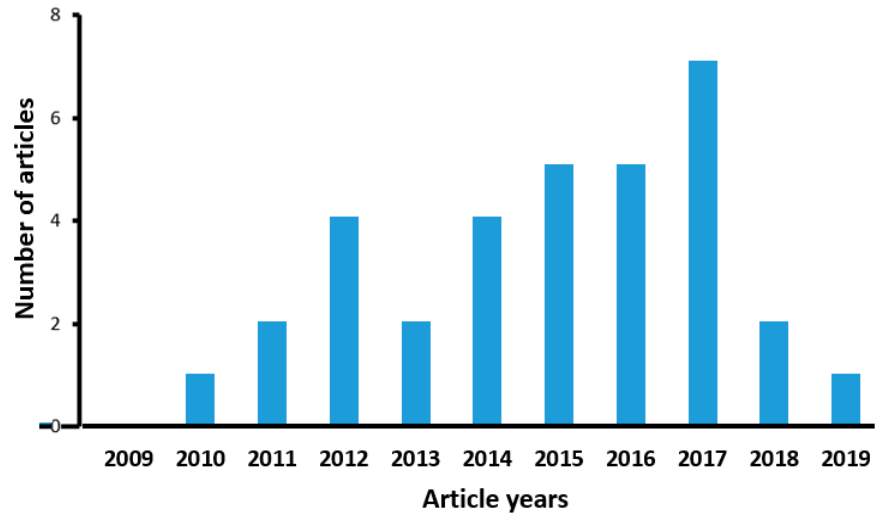
Figure 2. Number of articles having reported the criterion validity of instrumented insoles in the past 10 years, for steps, activity and posture detection.